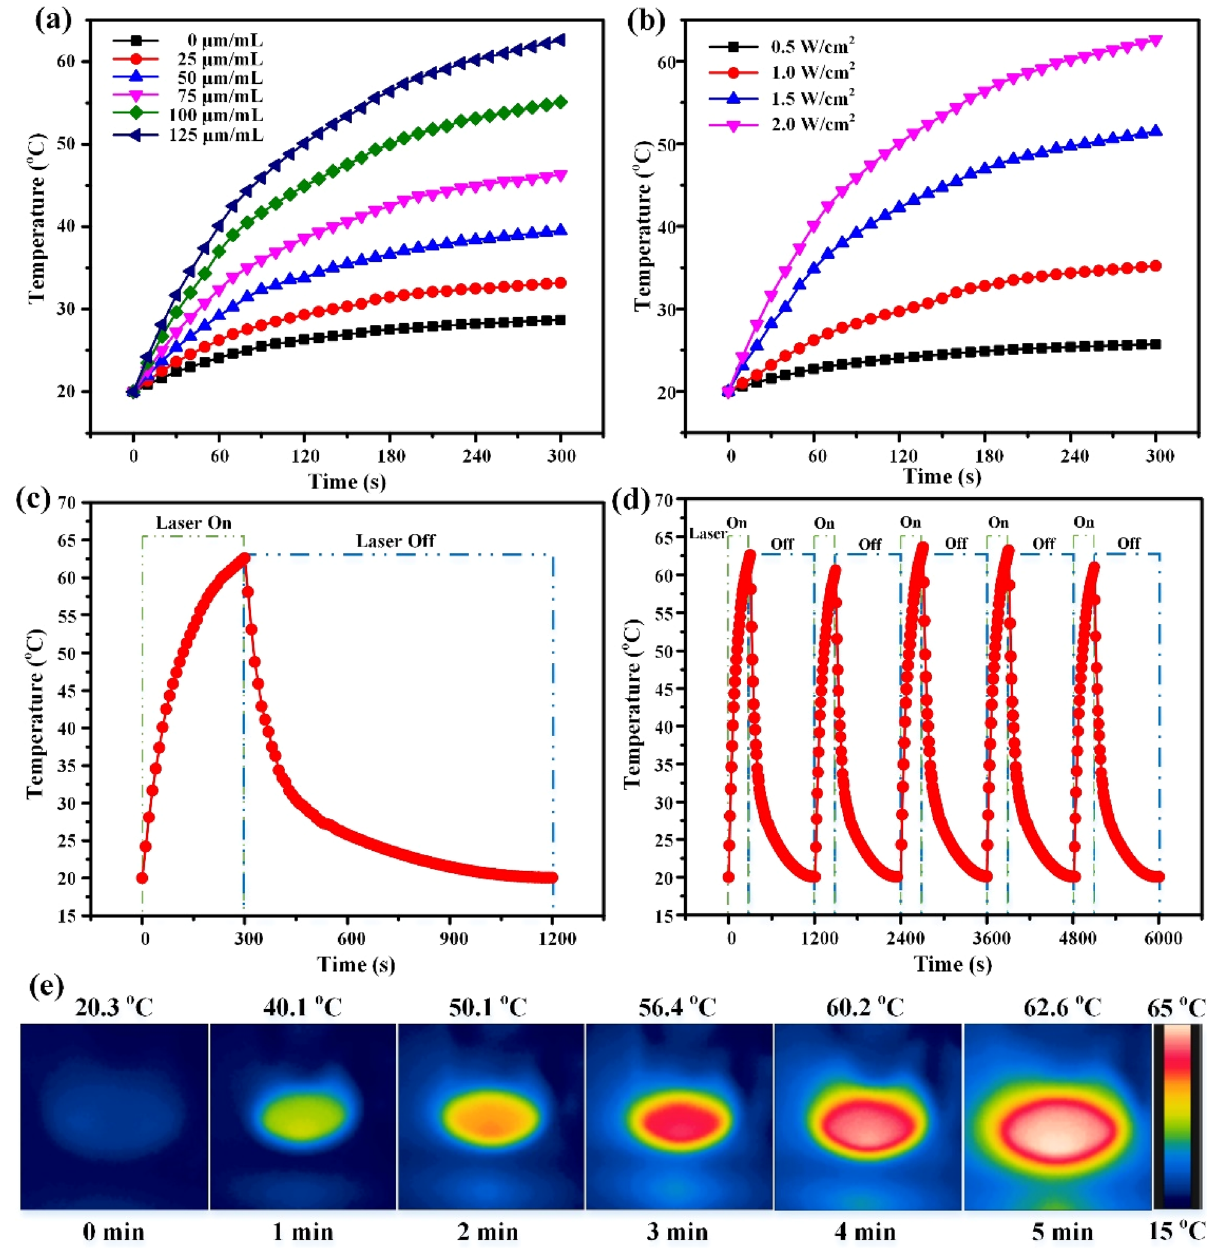
Figure 4. ( a ) The temperature elevation in an aqueous solution of different IR-CS–PPy NCs concentrations (0, 25, 50, 75, 100, 125 μg/mL) as a function of irradiation time by 808 nm laser at 2 W/cm 2 of laser power densities. ( b ) The temperature elevation of IR-CS–PPy NCs aqueous solution at a concentration of 125 μg/mL under 808- nm laser irradiation at different power densities (0.5 W/cm 2 , 1.0 W/cm 2 , 1.5 W/cm 2 , and 2.0 W/cm 2 ) for 5 min. ( c ) The photothermal response of IR-CS–PPy NCs (125 μg/mL) aqueous solution exposed to an 808-nm laser source at 2 W/cm 2 for 300 s and then the laser was shut off for about 900 s. ( d ) Temperature profiles of IR-CS– PPy NCs (125 μg/mL) aqueous solution for five on/off cycles. ( e ) The corresponding NIR thermographic images of the well containing IR-CS–PPy NCs (125 μg/mL) during 300 s of laser irradiation (2 W/cm 2